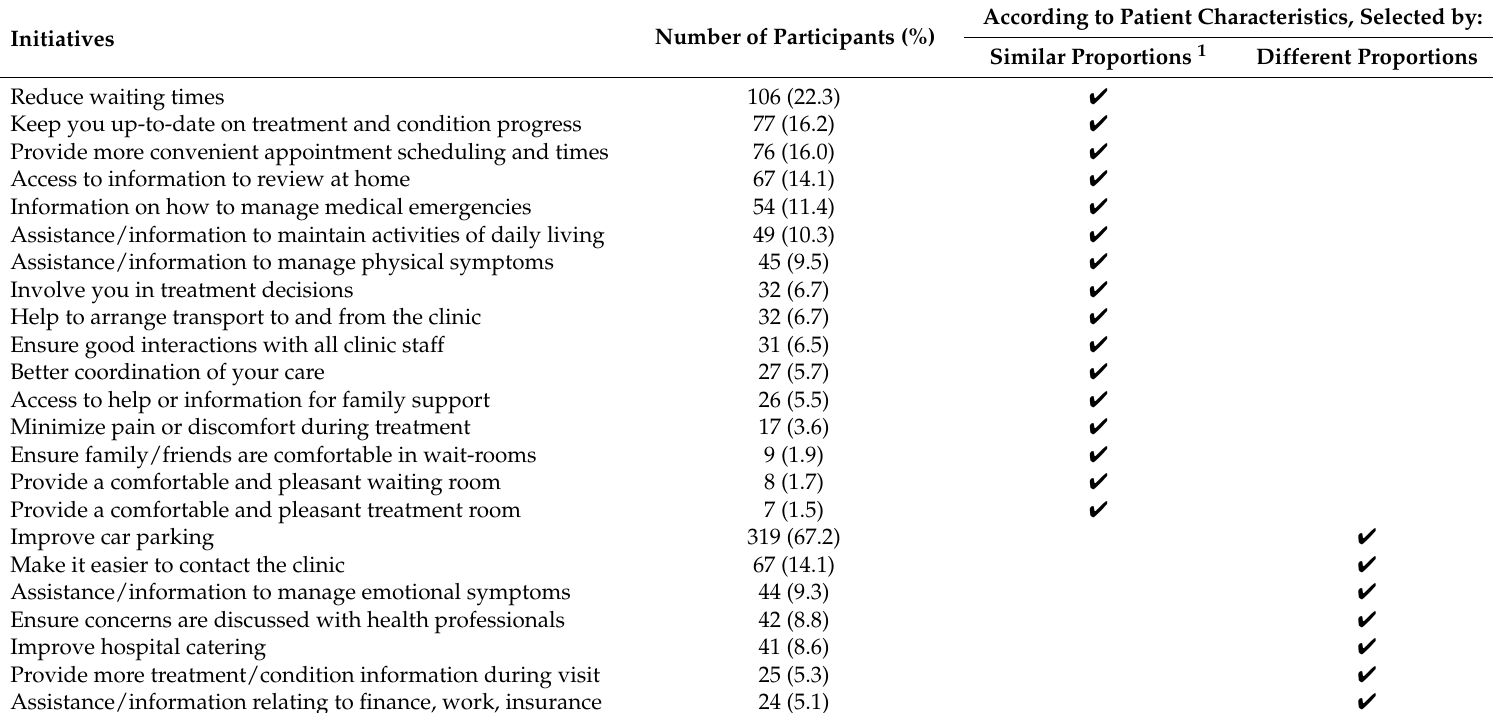
Table 2. Proportion of participants selecting each initiative and proportional differences according to patient characteristics identified Initiatives Number of Participants (%)